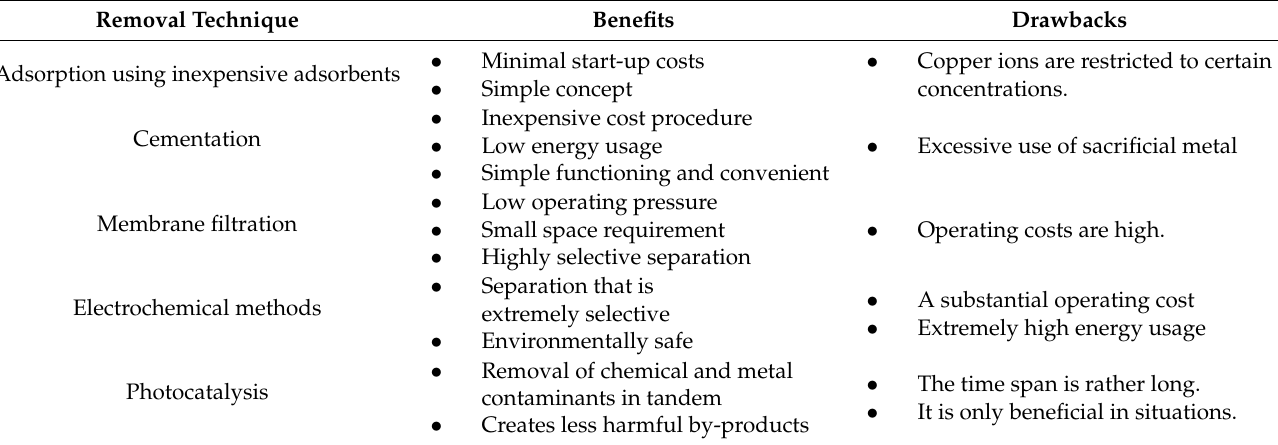
Figure 4. The process of copper removal from wastewater. Table 4. Advantages and disadvantages of different treatment methods.